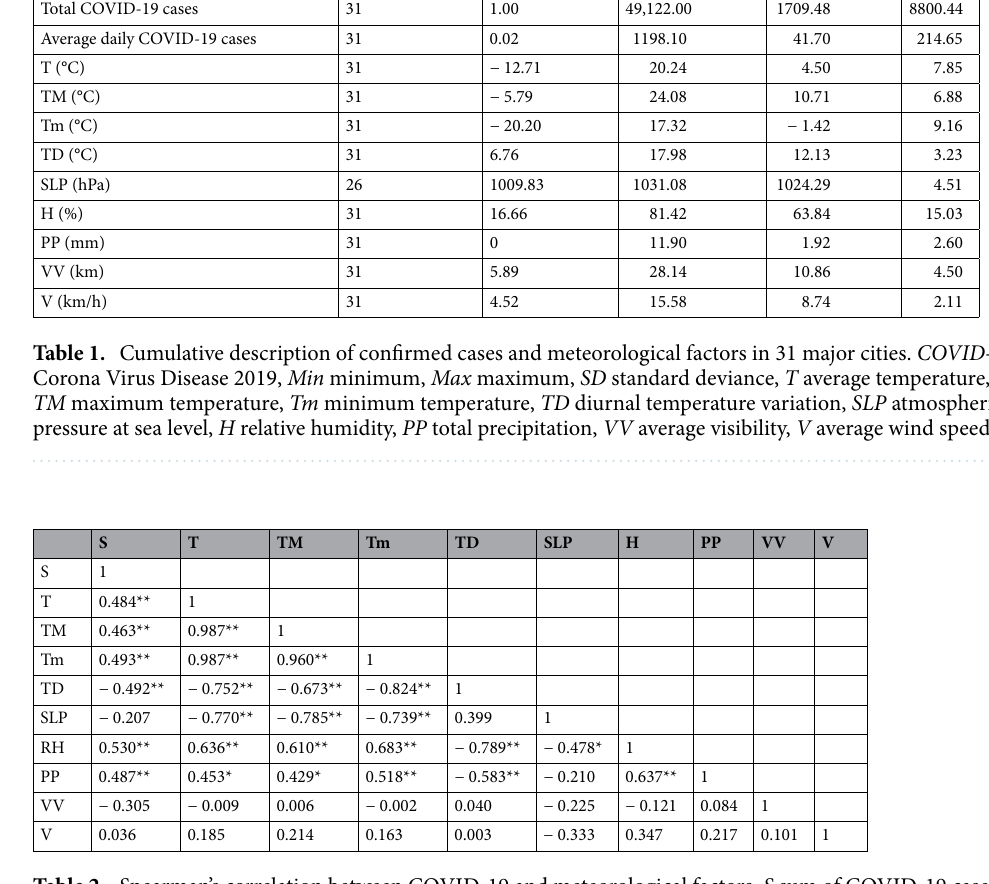
Table 2. Spearman’s correlation between COVID-19 and meteorological factors. S sum of COVID-19 cases, T average temperature, TM maximum temperature, Tm minimum temperature, TD diurnal temperature variation, SLP atmospheric pressure at sea level, RH relative humidity, PP precipitation, VV average visibility, V average wind speed. ** P < 0.01; * P < 0.05.